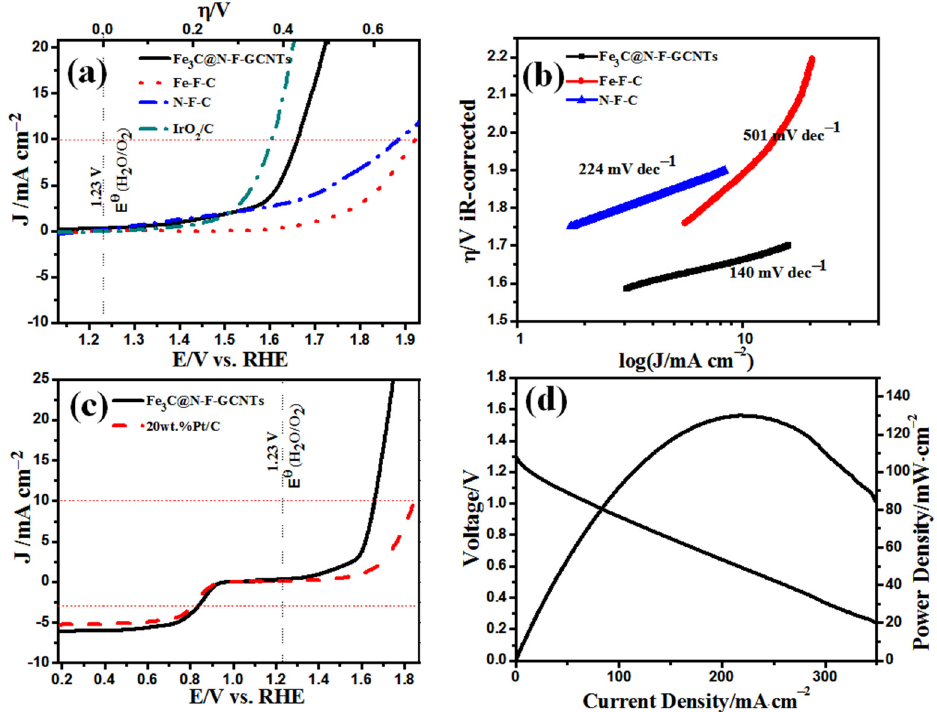
Figure 7. OER LSV curves of Fe 3 C@N-F-GCNTs, Fe-F-C, N-F-C, and 20 wt.% IrO 2 /C in O 2 -saturated 0.1 M KOH electrolyte solution at 1600 rpm ( a ); the corresponding Tafel plots of Fe 3 C@N-F-GCNTs, Fe-F-C, and N-F-C ( b ); the overall LSV curves of Fe 3 C@N-F-GCNTs and 20 wt.% Pt/C for ORR and OER ( c ); discharge polarization and power plots of Zn–air batteries using Fe 3 C@N-F-GCNTs as cathode ( d ).